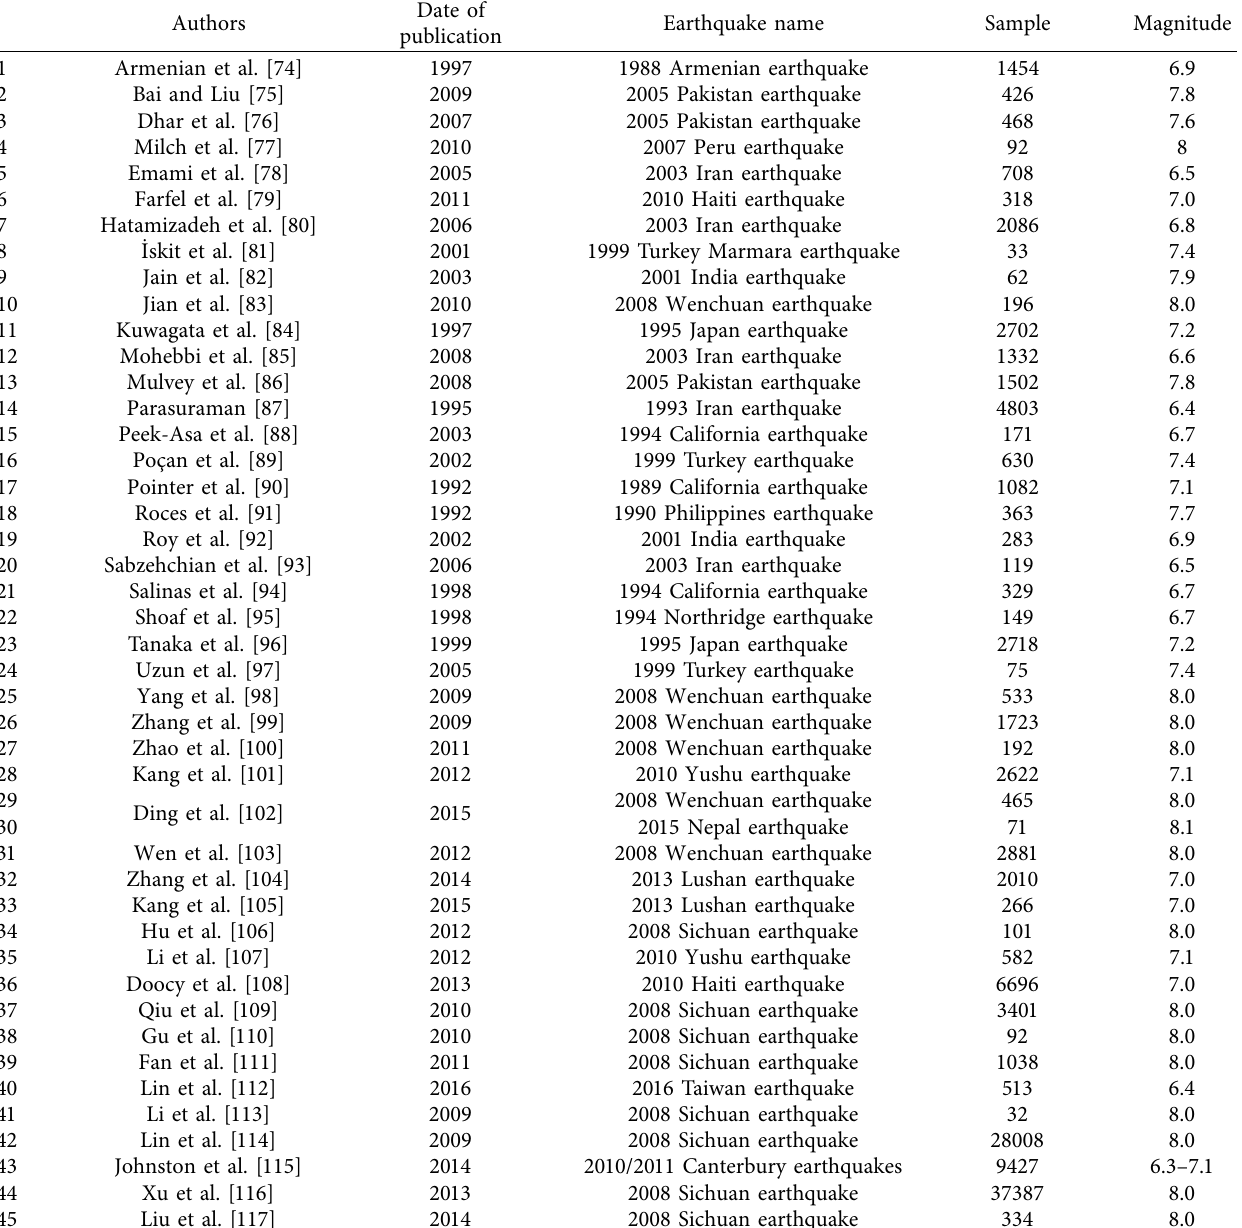
Table 4: Te general characteristic of the 47